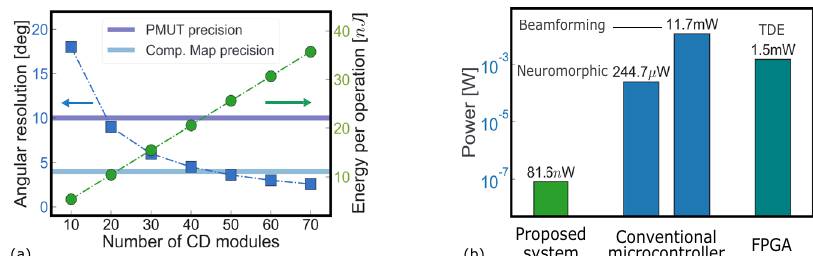
Fig. 7 Power consumption and angular resolution of the presented neuromorphic sensory and signal processing system. a Angular resolution (blue) and energy consumption (green) of one localization operation as a function of the number of CD modules. The dark-blue horizontal bar represents the angular precision of the PMUTs while the light-blue horizontal bar represents the angular precision of the neuromorphic computational map. b Power consumption of the proposed system and comparison with the two discussed implementations on a microcontroller and the digital implementation on an FPGA of the temporal-difference encoder (TDE)